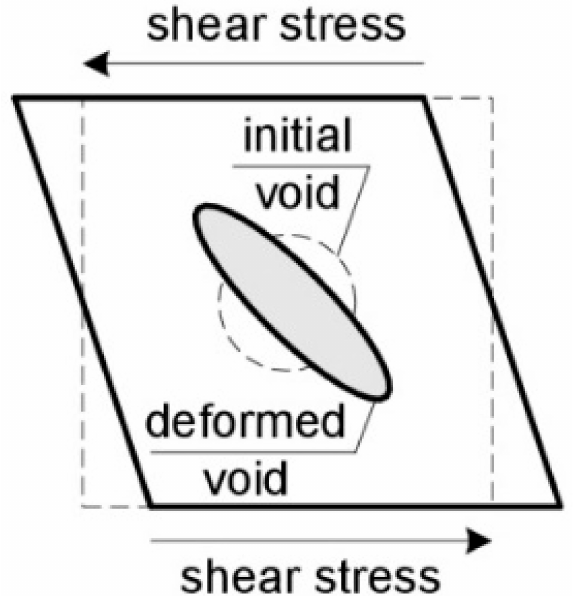
Figure 12. Void deformation and rotation under low